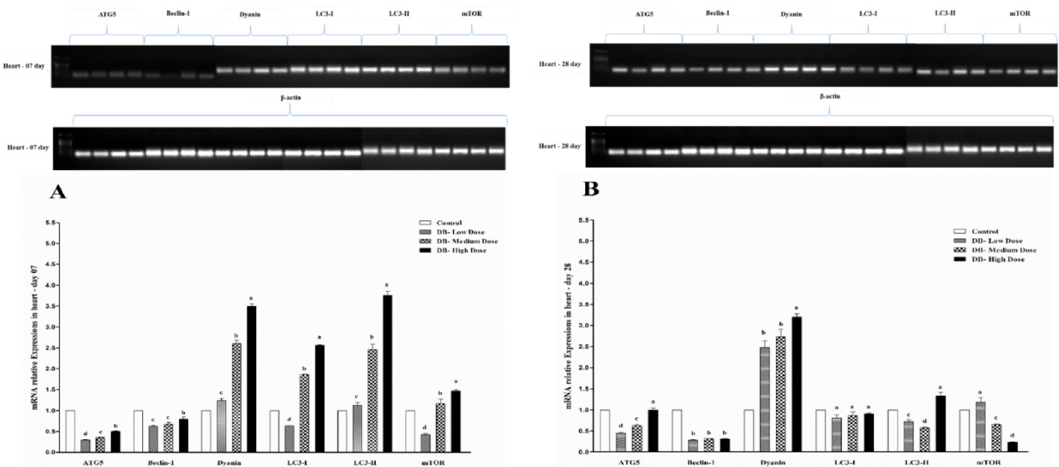
Figure 9. Effects of DB supplementation on heart mRNA expressions of autophagy- related genes at 07 days ( A ) and 28 days ( B ) of age. Data are presented as mean value ± SEM (n = 6). Values without the same mark (a–d) represent statistically significant differences ( p < 0.05). ATG5; Beclin 1; Dynein; LC3-I; LC3-II, mTOR; Denatonium benzoate- Low Dose treated group, Denatonium benzoate- Medium Dose treated group, Denatonium benzoate- High dose treated group.